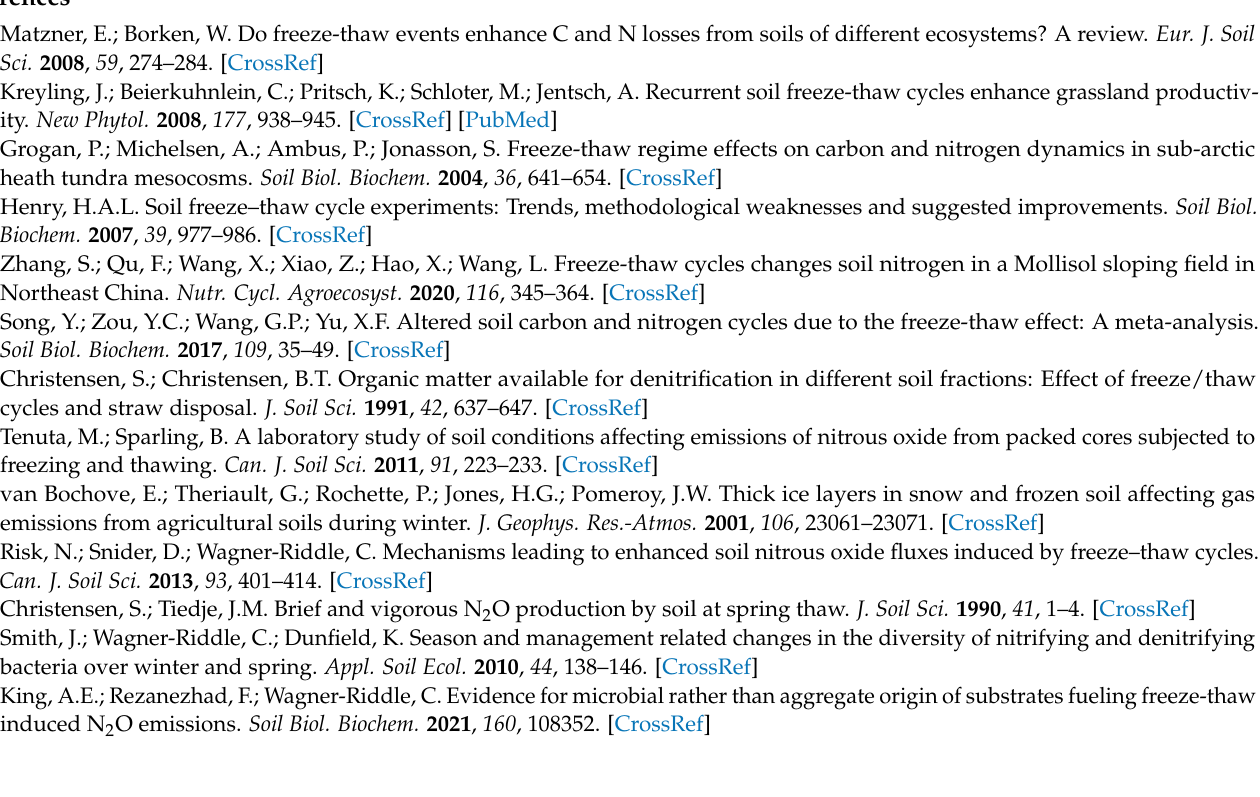
Figure S2: The top 20 dominant genera with the highest relative abundance in the three original soils (0 d) and in the CK treatment at different incubation time; Figure S3: The Pearson correlation between nitrification and denitrification functional genes abundance of the original soil and gas production rates in the CK